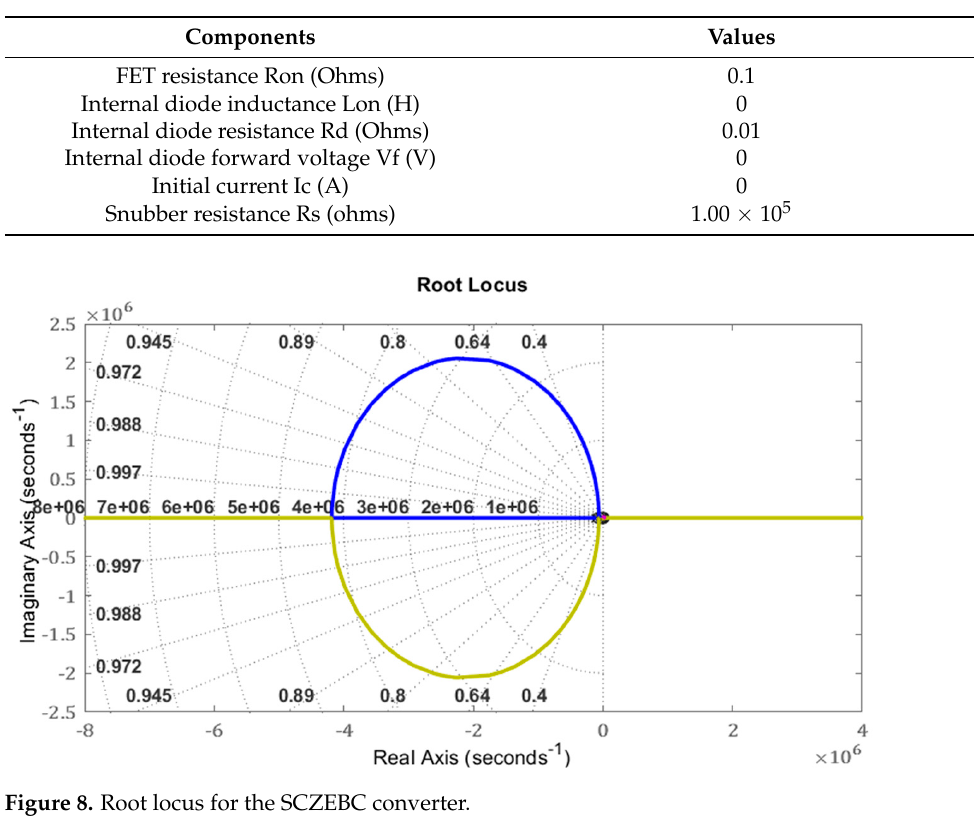
Figure 8. Root locus for the SCZEBC converter.